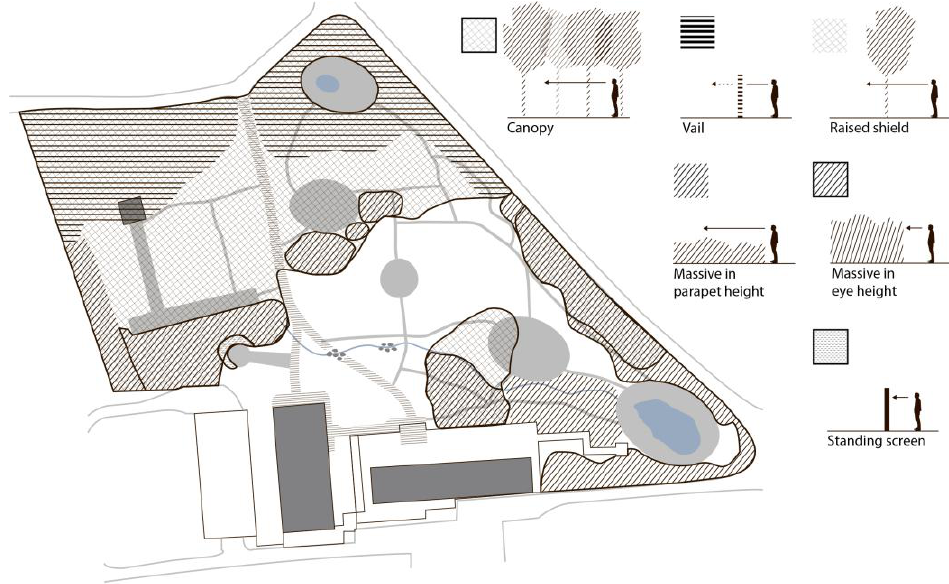
Figure 5. Physical conditions: Components which define walls and roof.